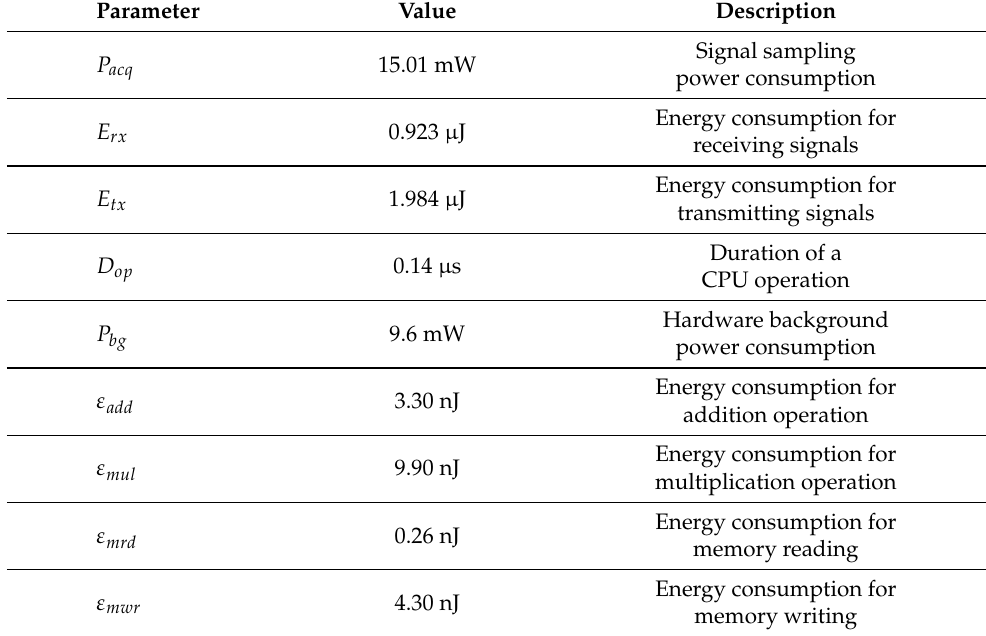
Table 1. Hardware